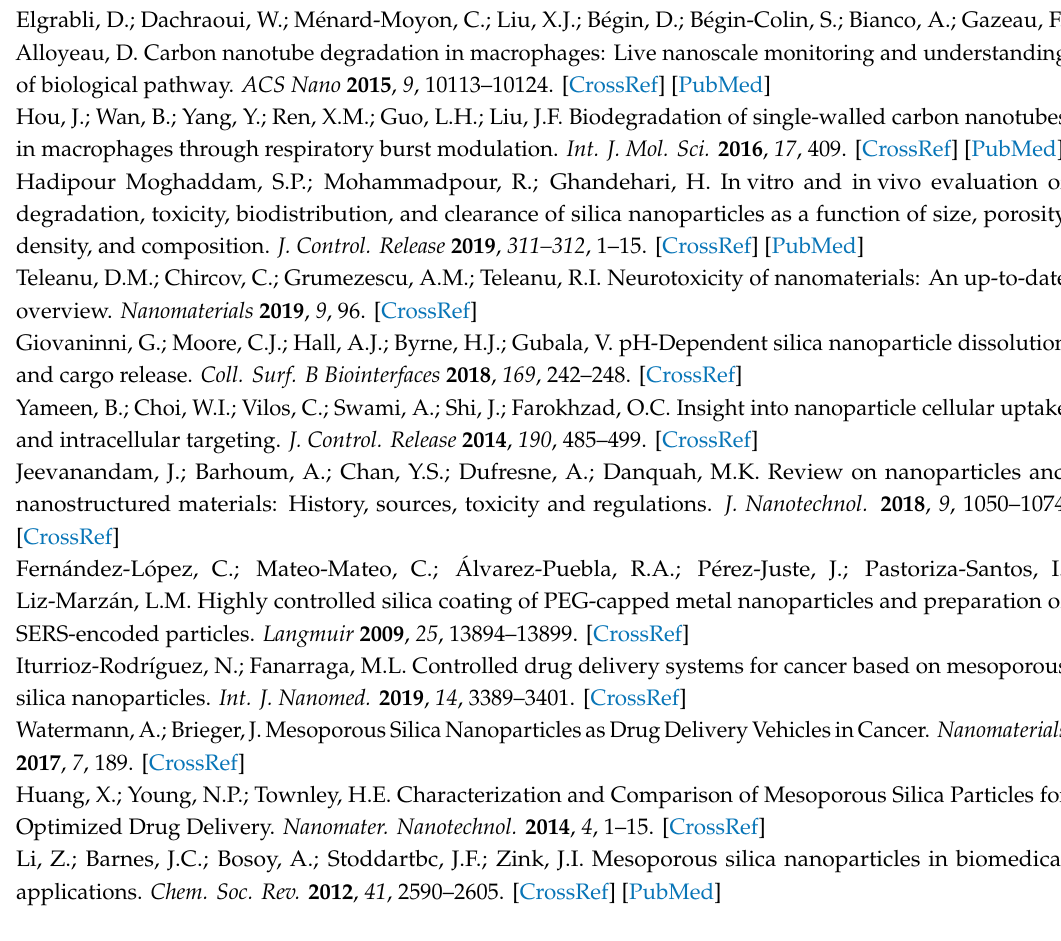
Figure S1: Characterization of the silica particles, Figure S2: Fluorescent confocal microscopy image of HeLa cells after 12 h of the administration of MSP, Figure S3: CNT:MSP escape from endo-lysosomes, Figure S4: Cytosolic particle surface